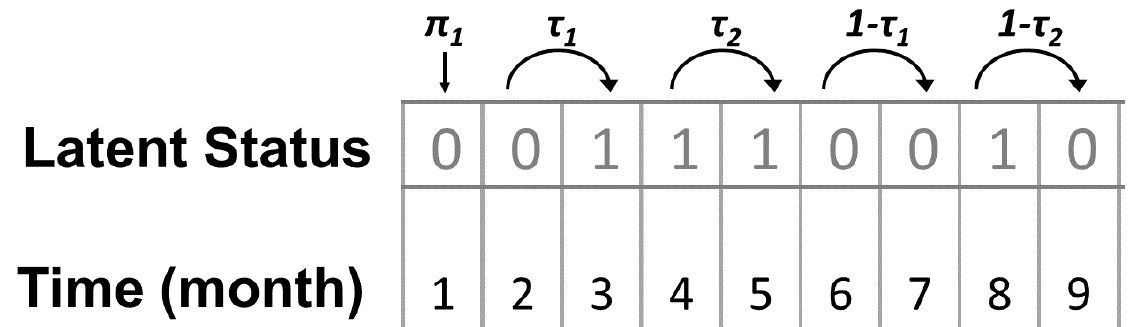
Figure 2 – Modelling of infection dynamics. The diagram shows hypothetical latent sta- tuses (0 for negative; 1 for positive) as a function of time in month, with examples of all possible transitions. π 1 = p ( S 1 = 1) is the probability of being status positive at the first S t point in time, τ 1 = p ( S t = 1 1 = 0) is the probability of becoming status positive and | − τ 2 = p ( S t = 1 S t 1 = 1) is the probability of remaining status | −